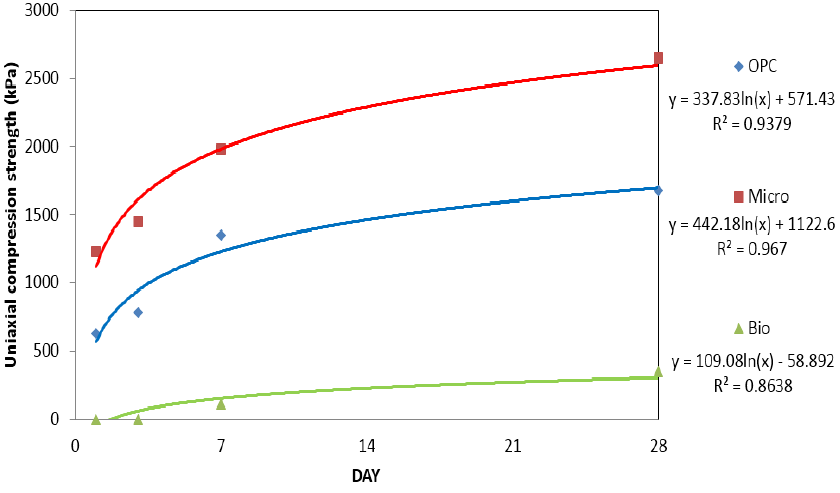
Figure 4. Uniaxial compression strength graphs for OPC, micro cement and bio grouting material. Table 2. Uniaxial compression strengths of OPC, micro cement and bio grouting material. Curing Time